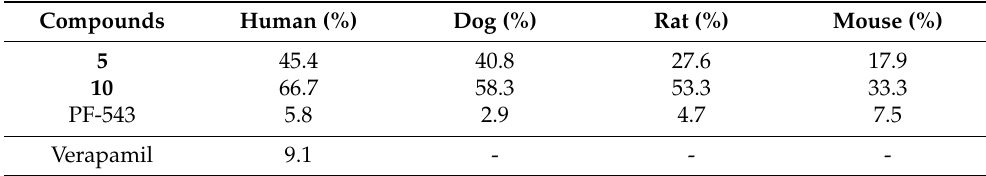
Table 1. In vitro stability study of compound 5 , 10 , and PF-543 compared with verapamil on human, dog, rat, and mouse liver microsomes. Compounds Human (%) Dog (%) Rat (%)